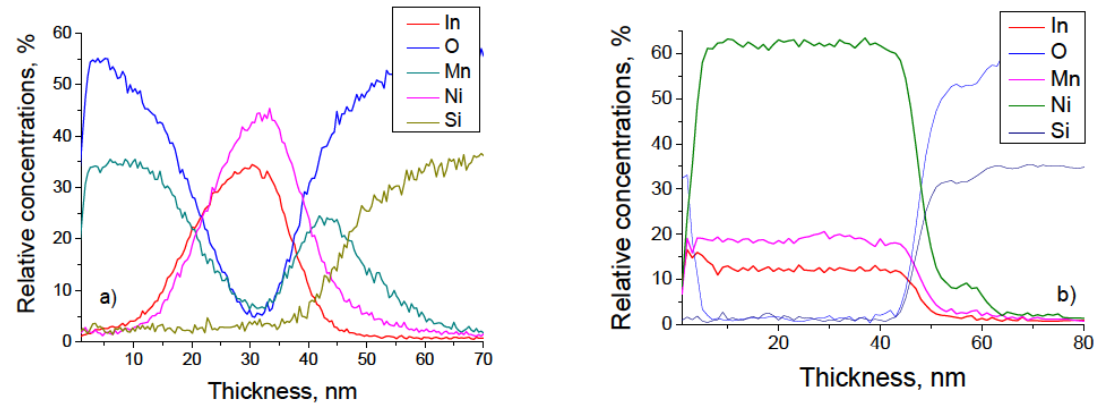
Figure 4: The distribution of elements by thickness, obtained by AES ion profiling. a) Ni-Mn-In sample, deposited in vacuum ~7 · 10 −4 Pa at room temperature with the following annealing under 325 ∘ C, b) Ni